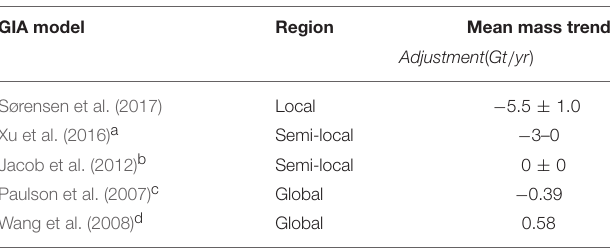
TABLE 2 | GIA adjustments for Iceland.